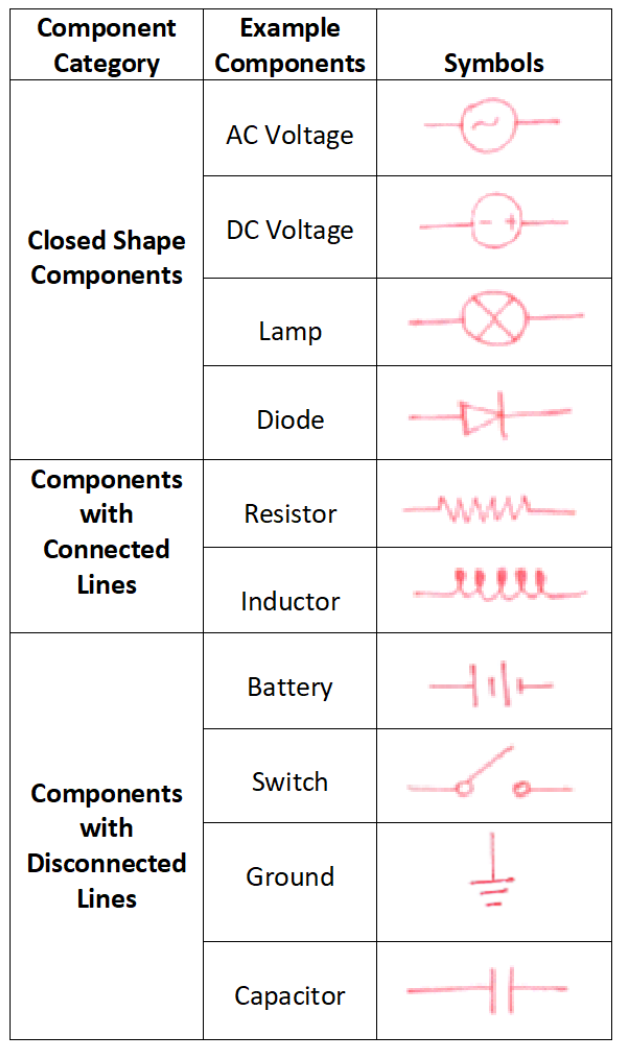
Figure 2. Component categories considered in our study